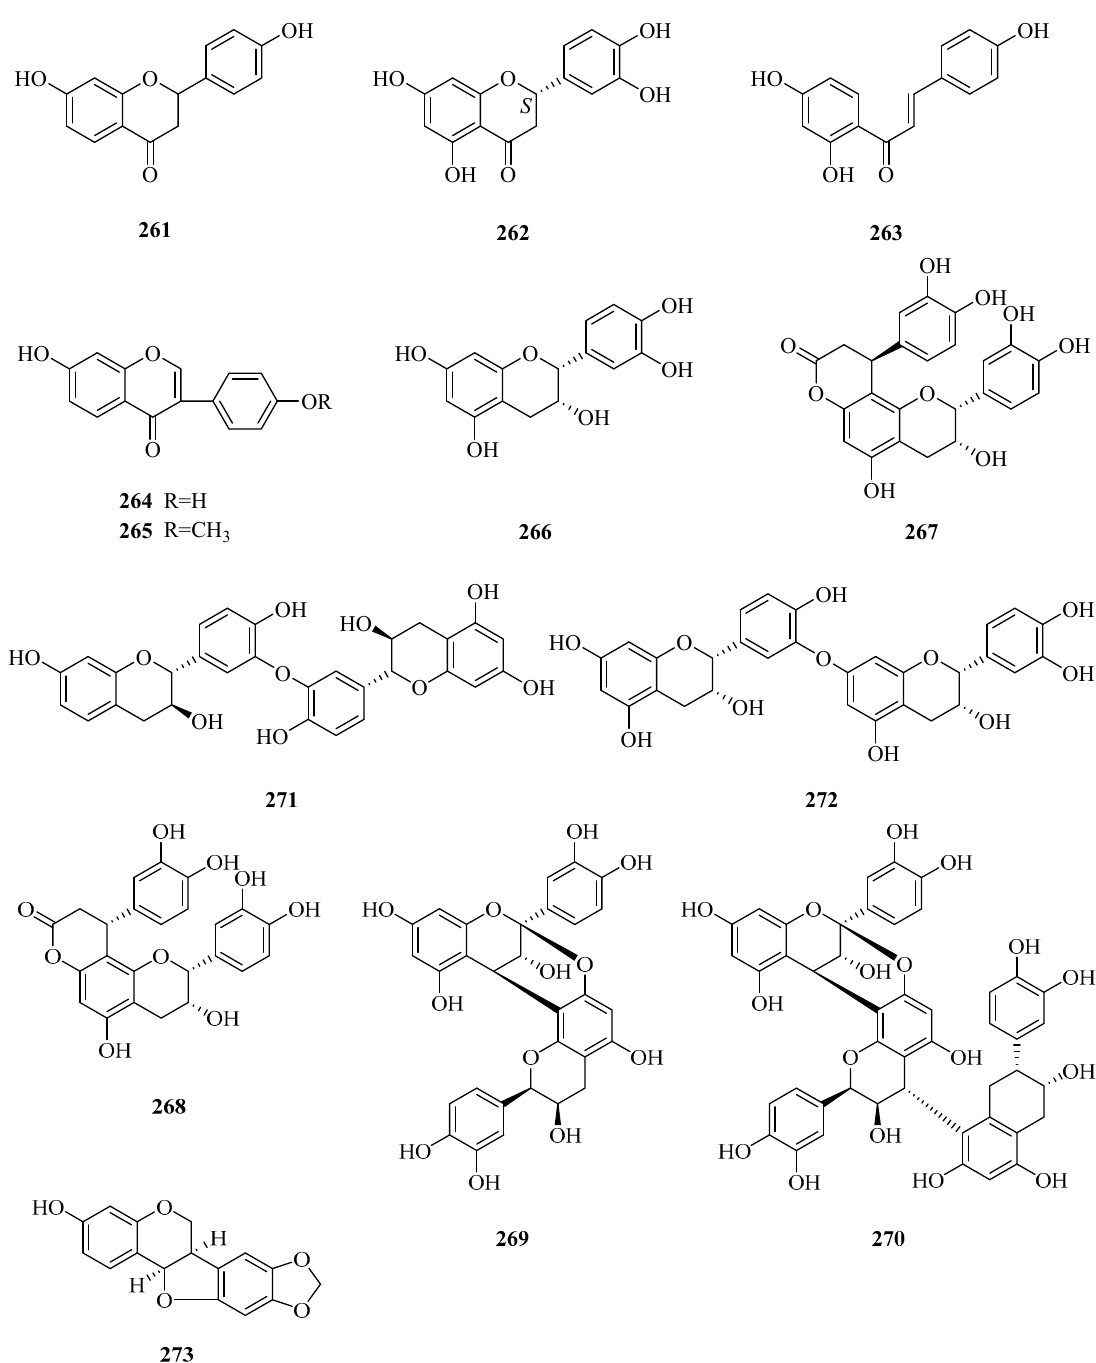
Figure 8. Flavonoids from the genus Periploca .